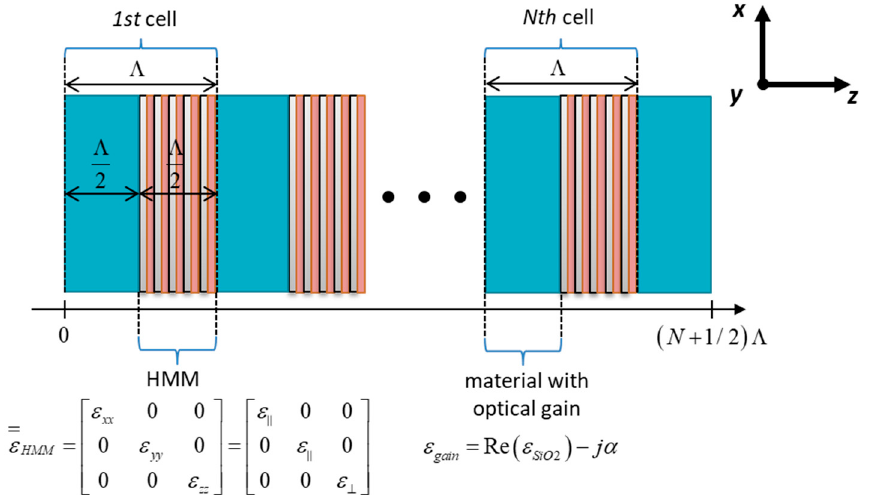
( ) ε Re j ε ε α= − , where corre- 2 SiO 2 gain SiO